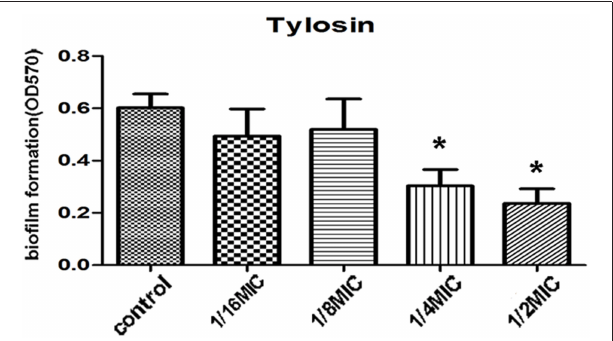
FIGURE 1 | Effect of tylosin at different concentrations on S. suis ATCC 700794 biofilm formation. The data are expressed as the means ± standard deviations. Significant decrease ( * p < 0.05) compared with control biofilm formation of S. suis in vitro .